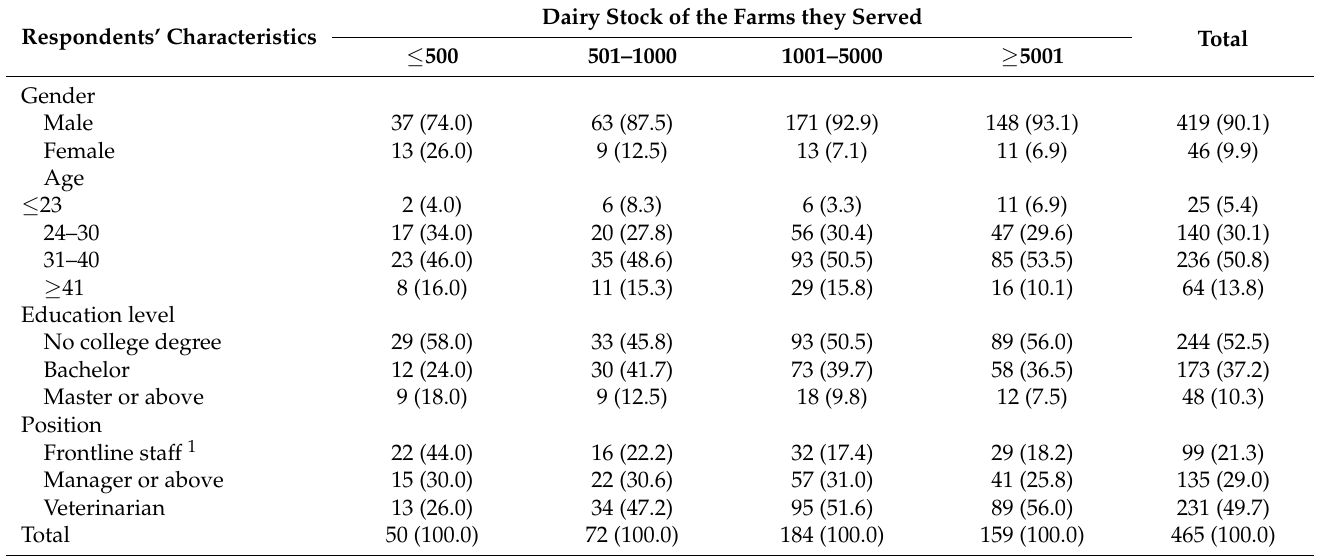
Table 1. The distribution of 465 respondents summarised by farm scale and presented as actual number ( n ) and proportion of each sub-category